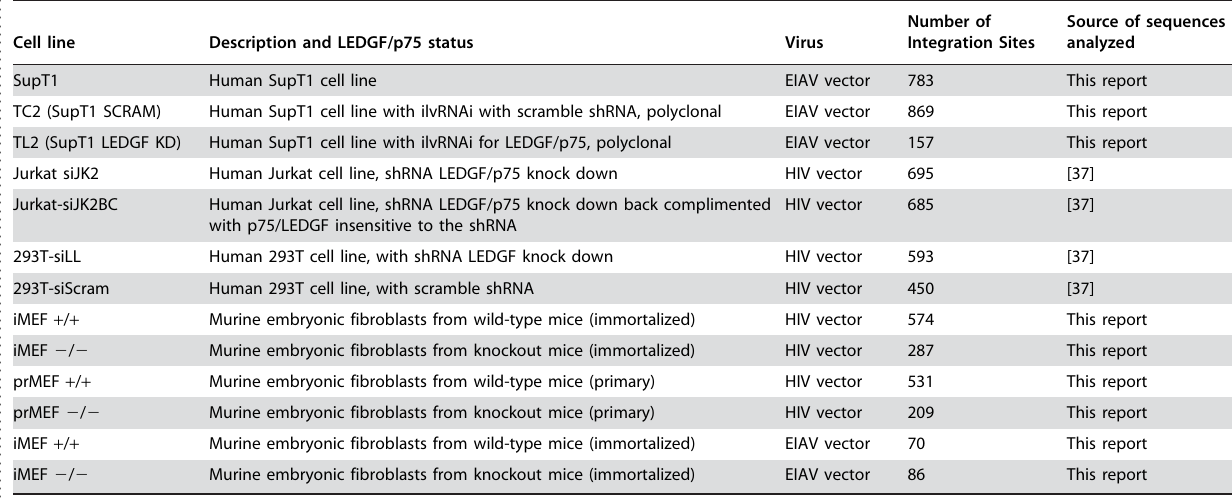
here for EIAV integration in the control SupT1 and SupT1 SCRAM cell lines (Figure 3A and B). The LEDGF/p75